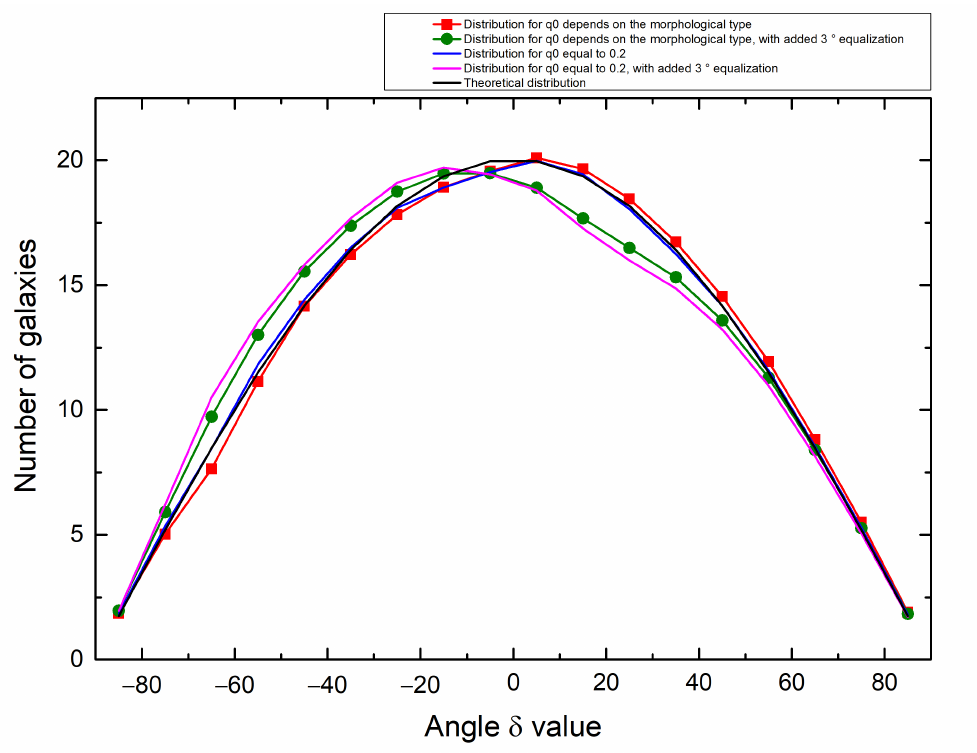
Figure 7. Simulated distributions of the angle δ D for group 42.